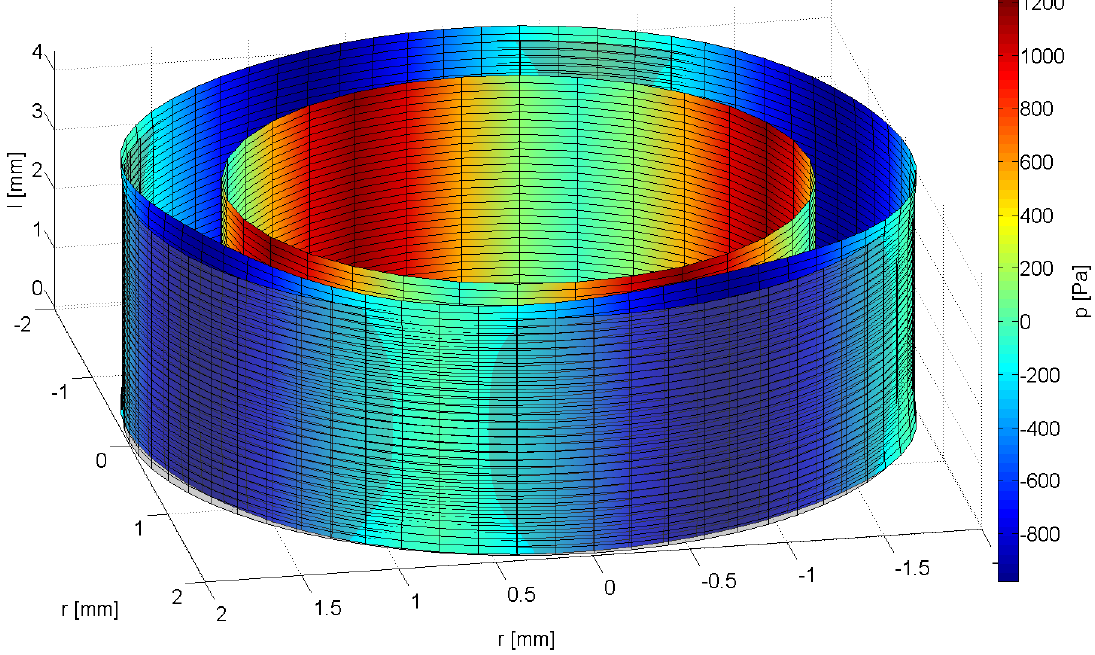
Figure 3. 3D-Representation of the deformed urethra model under